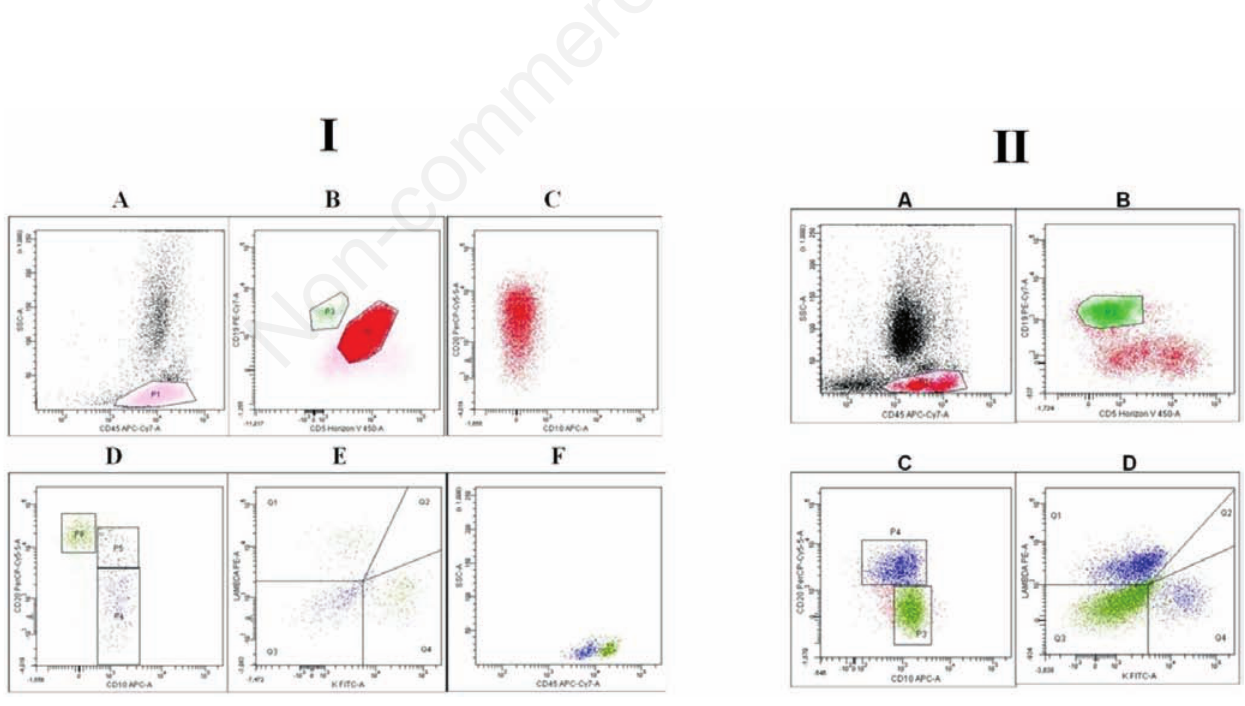
Figure 3. I. A case of CLL. A) initial gate (P1). B) detection of pathologic lymphocytes (P2) and CD19+/CD5-negative B-cells. C) the neoplastic lymphocytes are CD10-negative. D) CD19+/CD5- are composed of hematogones (P4+P5) and normal B-lymphocytes. E) different K/ l expression by hematogones and normal B-lymphocytes. F) back-gating. The P2 population represents 55% of total events, while P3 accounts for 0.5% of total events (hematogones: 0.2%; normal B-lymphocytes: 0.3%). II: a case of follicular lymphoma. A) initial gate (P1). B) CD19+ cells (10%). C) hematogones (P3, 5%) are present along with a pathologic, CD10+/CD20+ mature B-lym- phocyte population (P4, 5%), which shows D) clonal l excess (K/ l ratio: